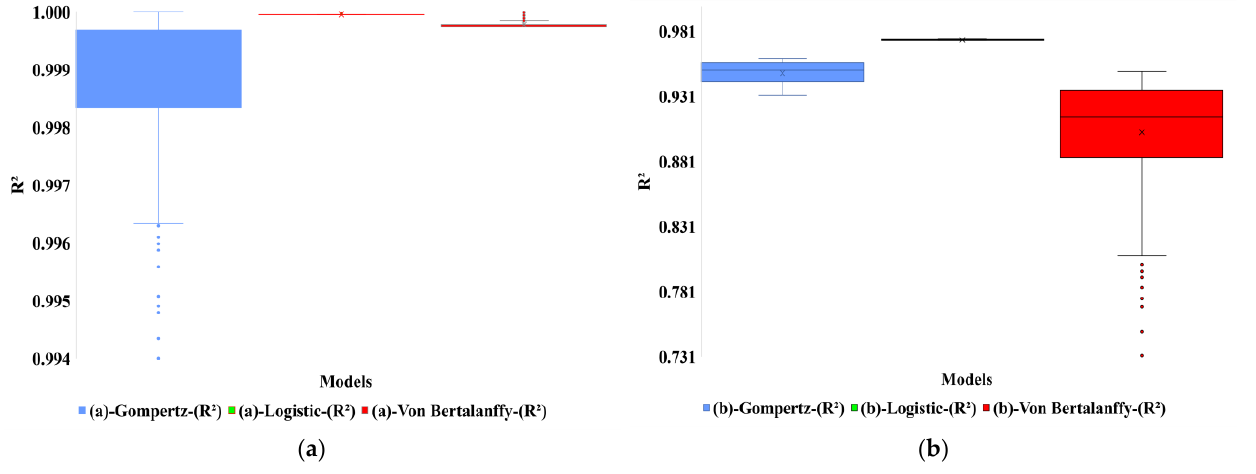
Figure 6. Descriptive analysis of experimental data from 300 assays of performance of SAGAC algorithm in process optimization for broilers ( a ) and pigs ( b ).